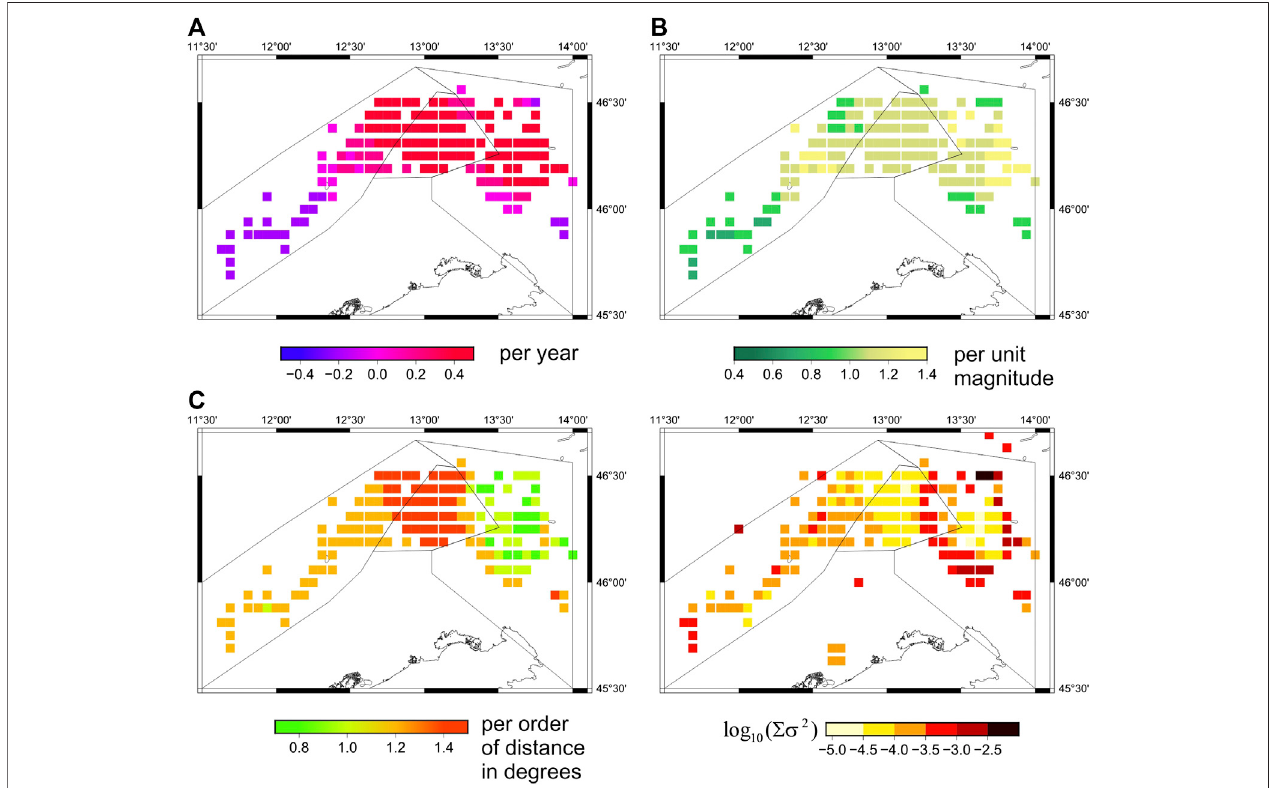
FIGURE 5 | The regional maps of A, B, and C coef fi cients (top panels) and spatial distribution of the sum of standard errors (cid:1) σ 2 (cid:2) σ 2 A + σ 2 B + σ 2 C . Color code symbols correspond to estimates associated with cells of size 1/16 ° × 1/16 ° .